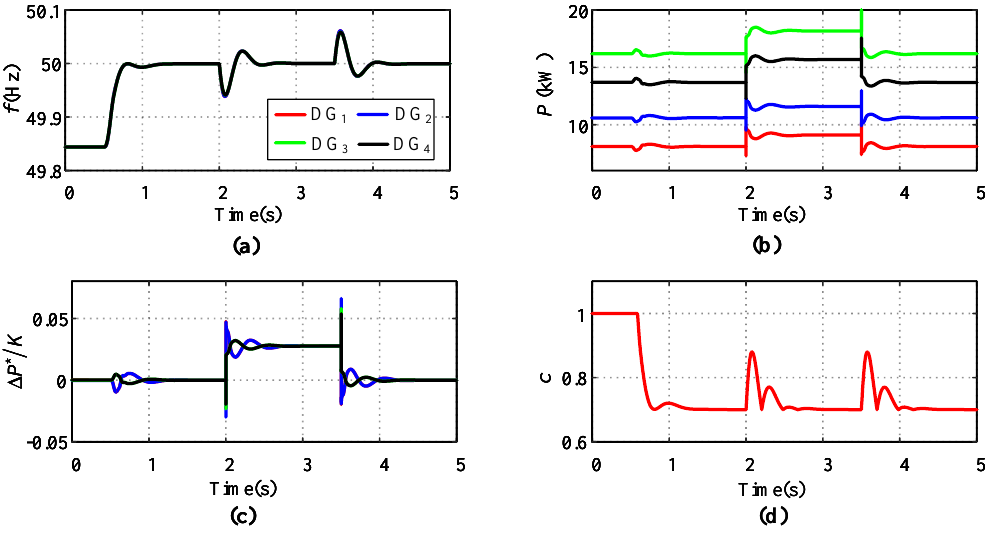
Figure 6. The dynamic responses of study 1 with delay time τ =0.2 s: ( a ) frequency; ( b ) active power; ( c ) ratio of the incremental of power’s nominal valueto the droop coefficient; ( d ) adaptive